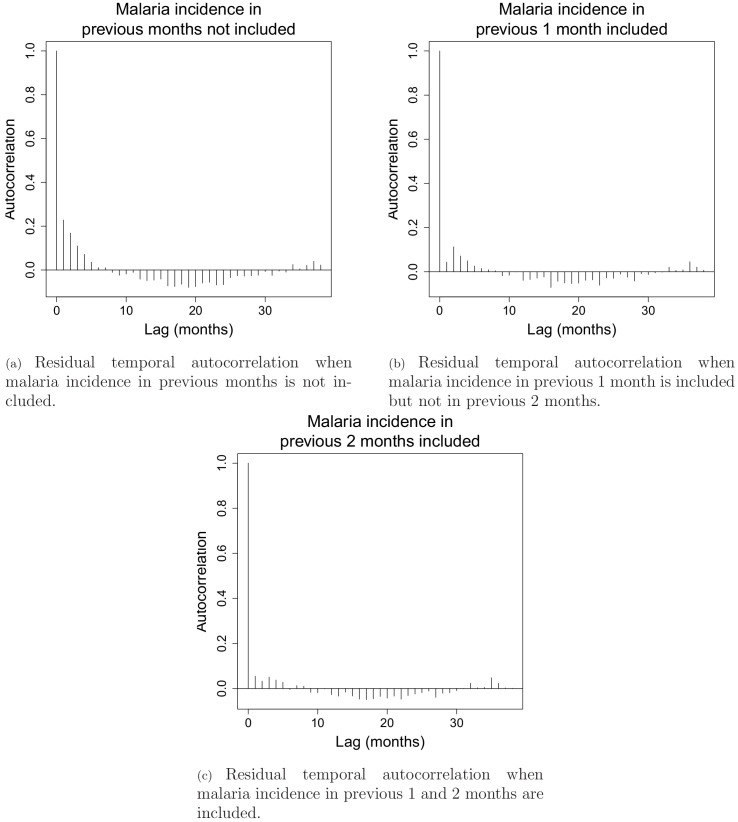
Residual temporal autocorrelation when malaria incidence in previous 1 and 2 months are included or not.